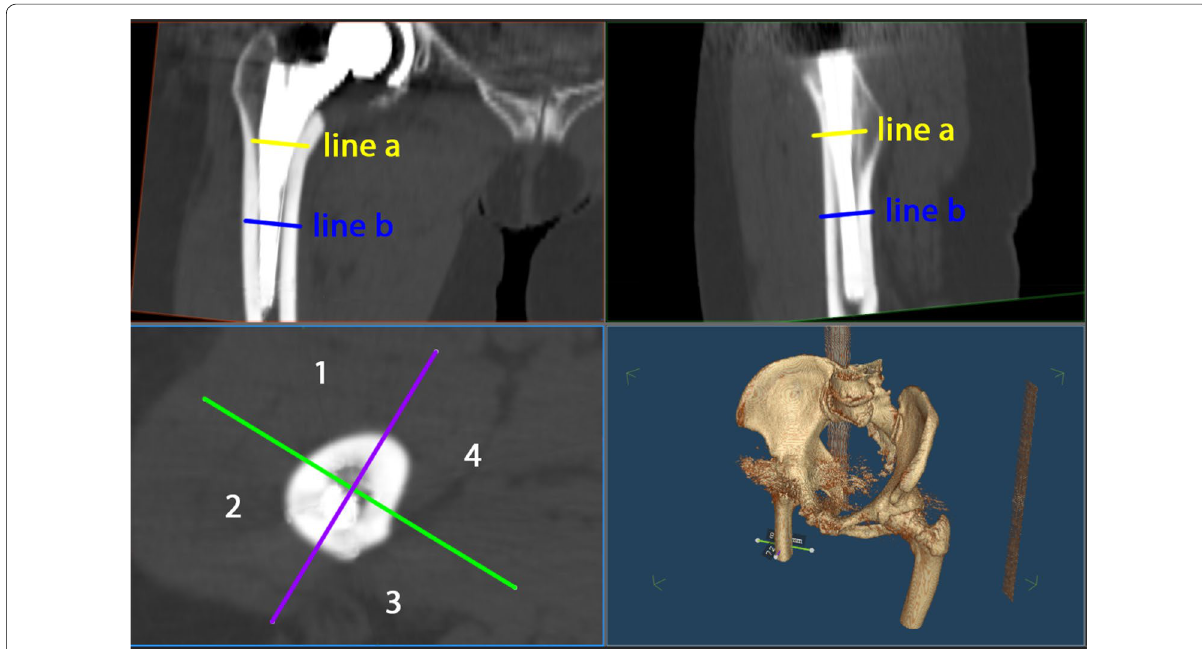
Fig. 5 The screenshot of the used software shows the contact points of the implant with the femoral cortical bone. In this example, the implant has contact with the ventral cortical bone in the upper and middle third and with the dorsolateral cortical bone in the lower third. 1 2 lateral, 3 dorsal, 4 medial = = =